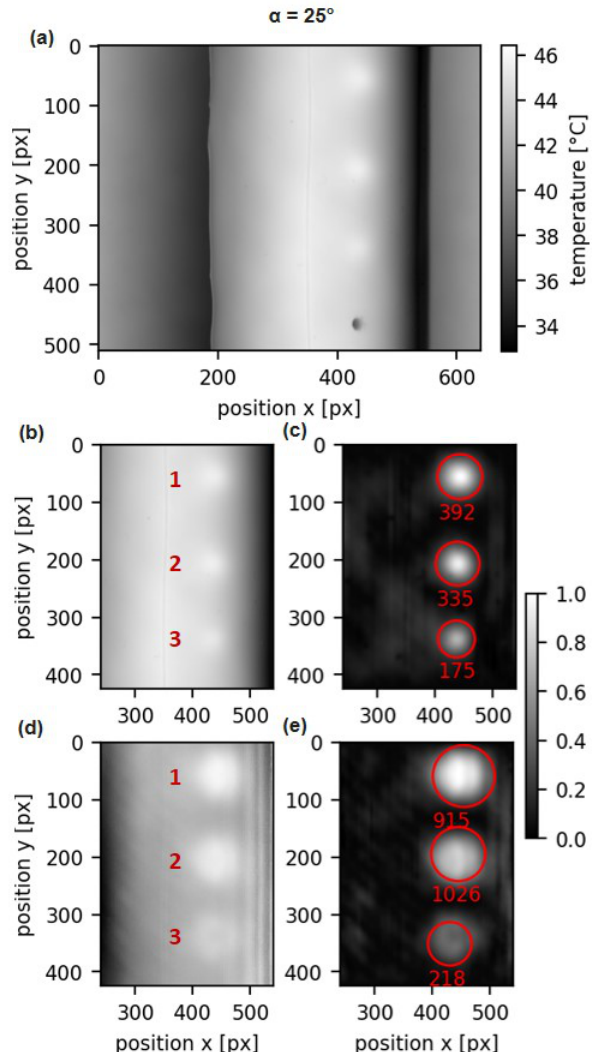
Figure 9. Results of test series 3 ( α = 25 ◦ , ROI A, t exc = 25s, t rec = 15s, k = 89mm, ( a ) surface temperature of the whole camera FOV, ( b ) result for the reference method without filtering at t rec = 0s, ( c ) reference image with filtering, automatic defect detection and calculation of the CNR, ( d ) result for the PCA-based method without filtering, ( e ) PCA-based image with filtering, automatic defect detection and calculation of the